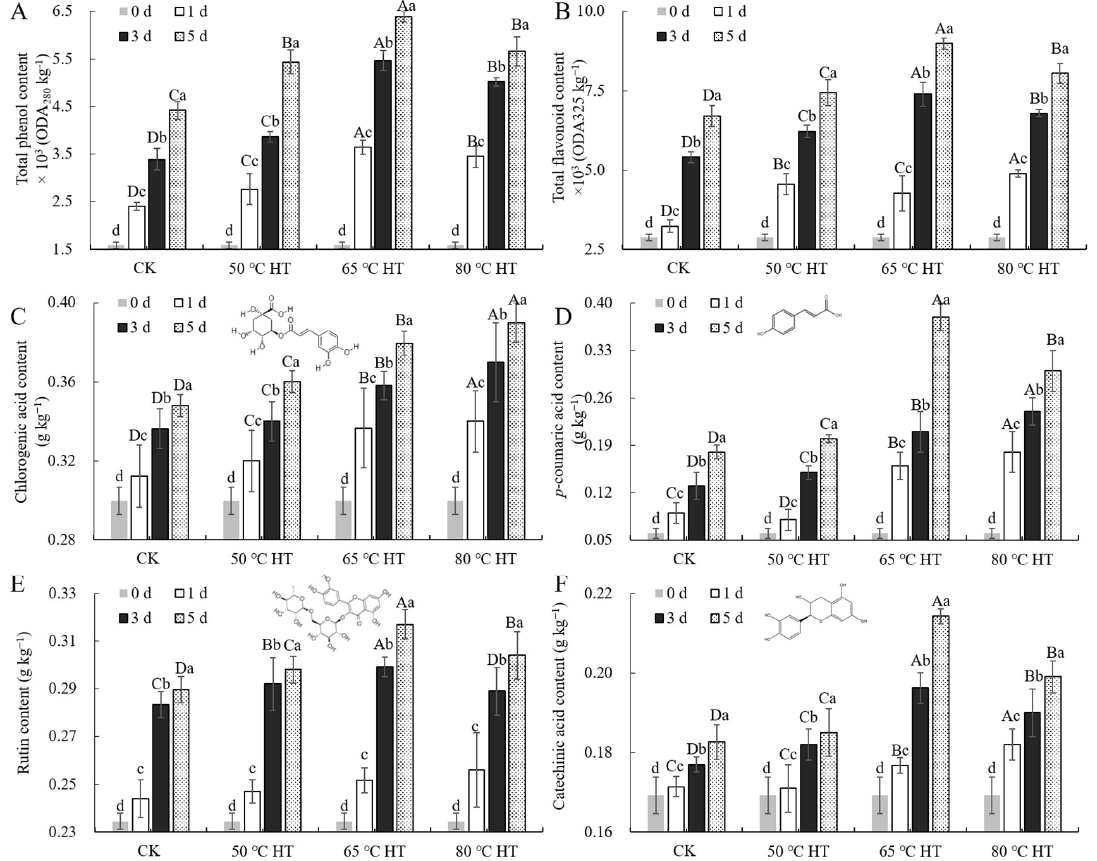
Figure 3. Effects of RHT treatment on total phenol, total flavonoid, chlorogenic acid, p-coumaric acid, rutin, and catechin content in sweet potato callus (( A ): Total phenol content; ( B ): Total flavonoid content; ( C ): Chlorogenic acid content; ( D ): p-coumaric acid content; ( E ): Rutin content; ( F ): Catechinic acid content. Note: Capital letters are comparisons at the same time at different temperatures, and lowercase letters are comparisons at different times at the same temperature).